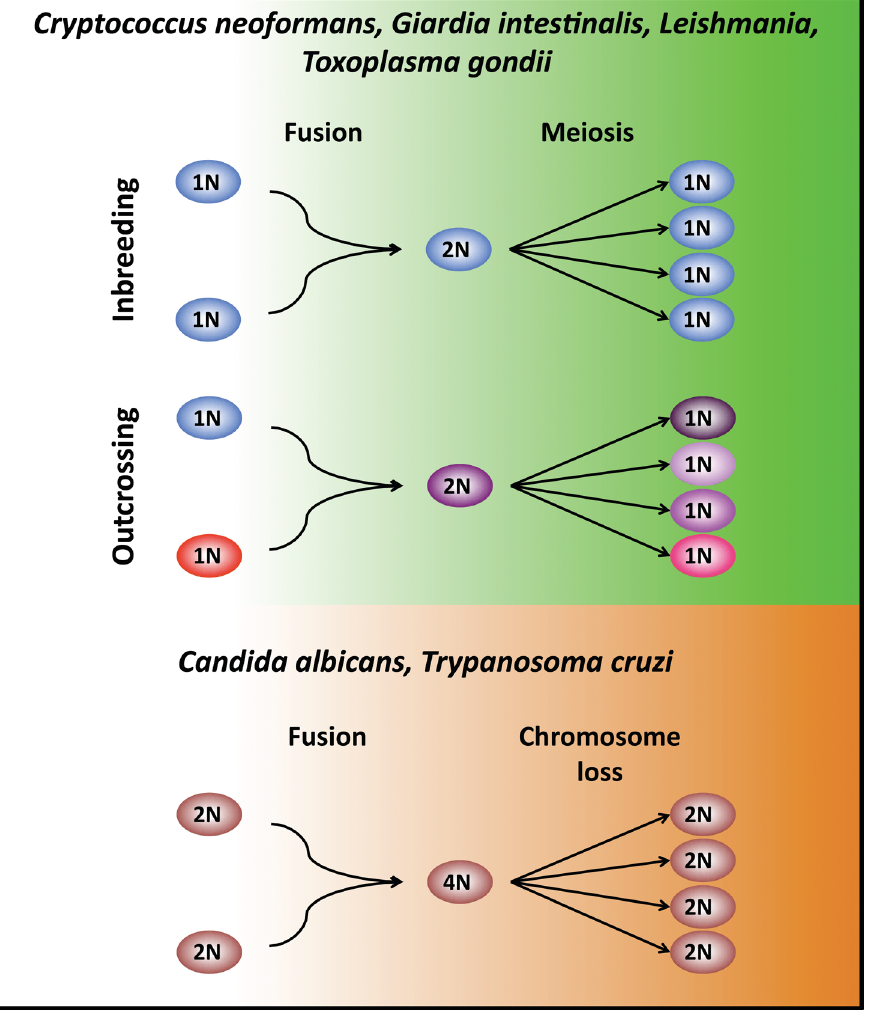
Figure 1. Modes of unisexual reproduction. In haploid eukaryotes, cells (1N) of the same mating type can fuse or undergo endoreplication to generate a diploid intermediate (2N). DNA replication without cell division follows and meiosis produces four recombinant progeny (1N). Unisexual reproduction can also occur in 1) a clonal population, promoting inbreeding, or 2) between cells of the same mating type but of distinct genetic lineages to enable outcrossing. A similar unisexual cycle is observed in Candida and possibly also Trypanosoma , where diploid cells (2N) fuse to generate a tetraploid intermediate (4N). The resulting tetraploid cells (4N) return to the diploid state (2N) through either parasexual chromosome loss that occurs stochastically independent of meiosis ( C. albicans , and possibly T. cruzi ) or sexually via meiosis ( T. brucei